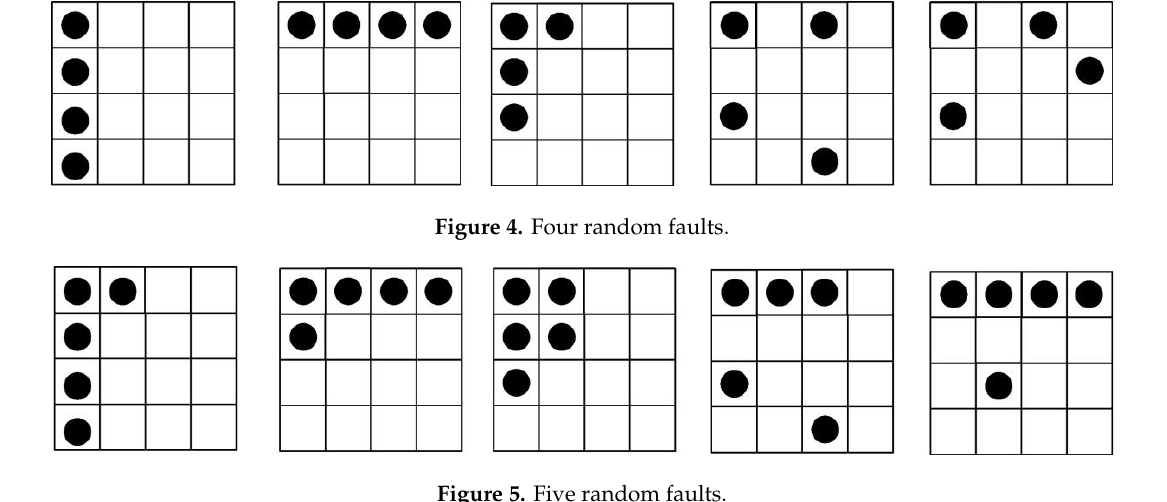
Figure 5. Five random faults.